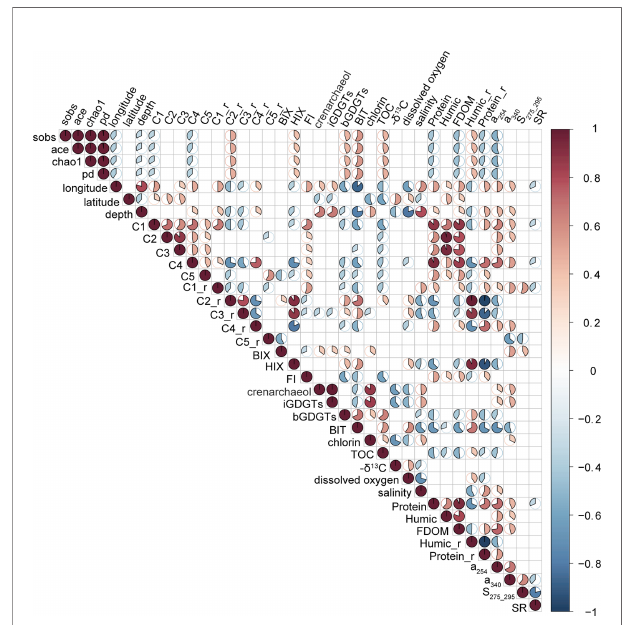
FIGURE 4 | Correlation analysis between signi fi cant factors and bacterial taxa (top 30) at the order level. Spearman ’ s rank correlations are indicated by colors, with red for positive correlations and blue for negative ones. BIX, biological index; FI, fl uorescence index; bGDGTs, branched glycerol dialkyl glycerol tetraethers; TOC, total organic carbon; C1-C5, fl uorescence intensity in the Raman Unit of C1-C5; C1_r-C5_r, proportions of total intensity (i.e., relative intensity) of C1-C5. Signi fi cant factors are shown within brackets in the second column. Signi fi cance labels: ***p < 0.001, **p < 0.01, *p < 0.05.